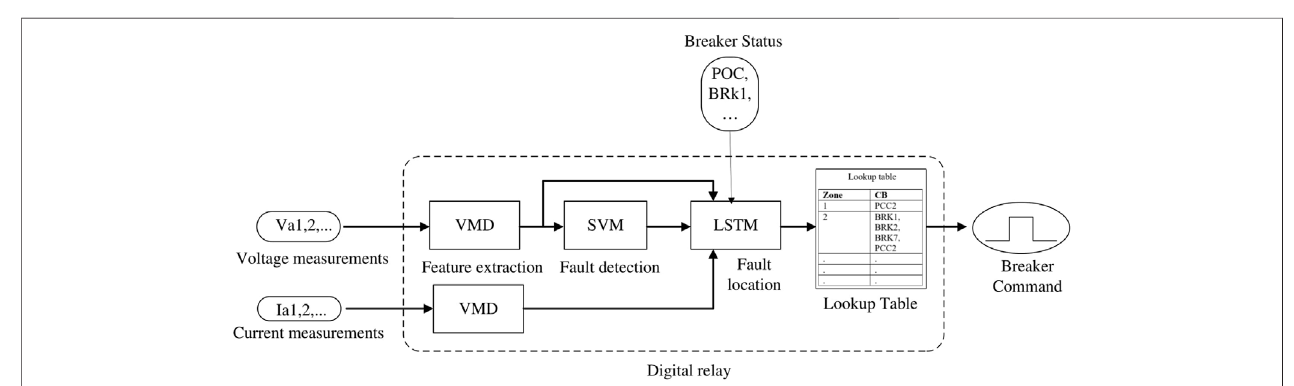
FIGURE 7 | Structure of designed digital protection